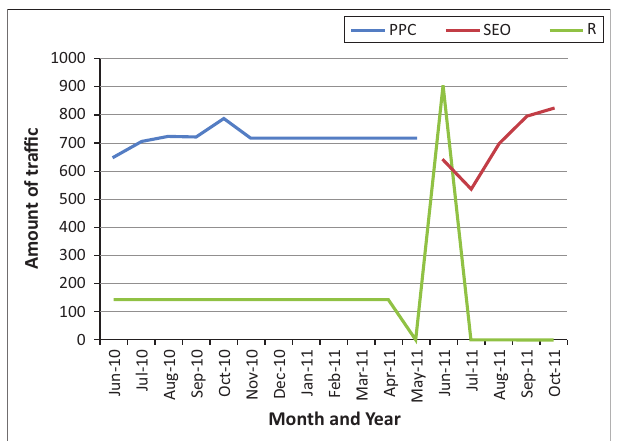
FIGURE 7: Summary of traffic versus expenditure.